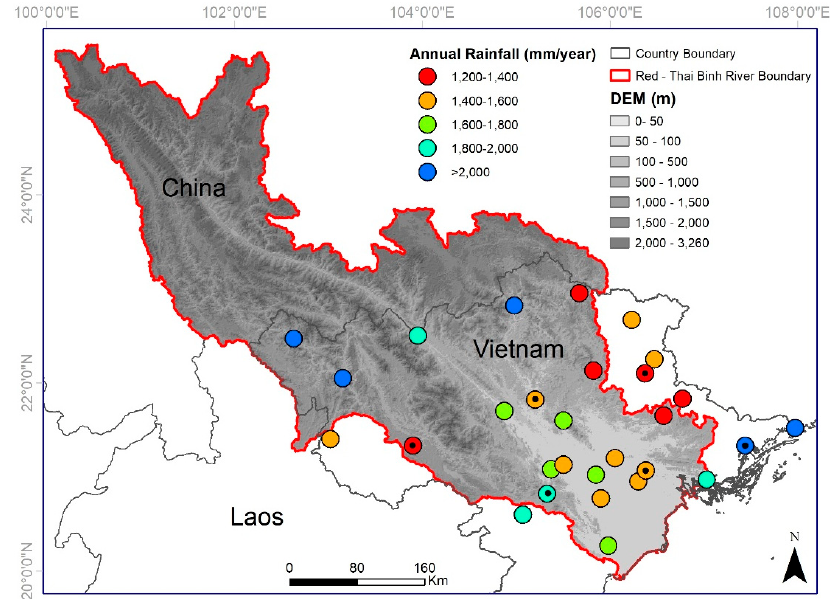
Figure 1. Overview of Red–Thai Binh River Basin. The stations with black dots at the middle were used for calibration climatology–topography-based linear-scaling approach.